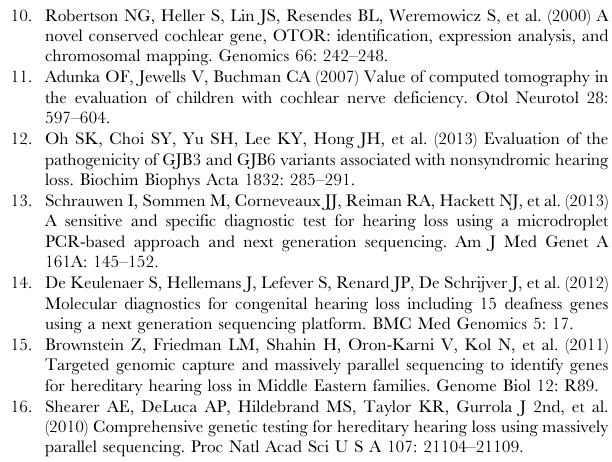
Figure S1 Audiogram and pedigree for 12 familial NSHL used in PCR-Sanger sequencing. Figure S2 Audiogram and pedigree for 20 familial NSHL for targeted resequencing. Figure S3 Heatmap for percentage of bases $ depth 10, 50 or 100 within all target exons and samples. Most exons were uncaptured in common samples and samples were grouped by the common uncaptured exons. Figure S4 Barplot for comparison between experimental and expected distribution in number of exons that were commonly uncaptured within from 0 to 20 samples. Note that the exons in